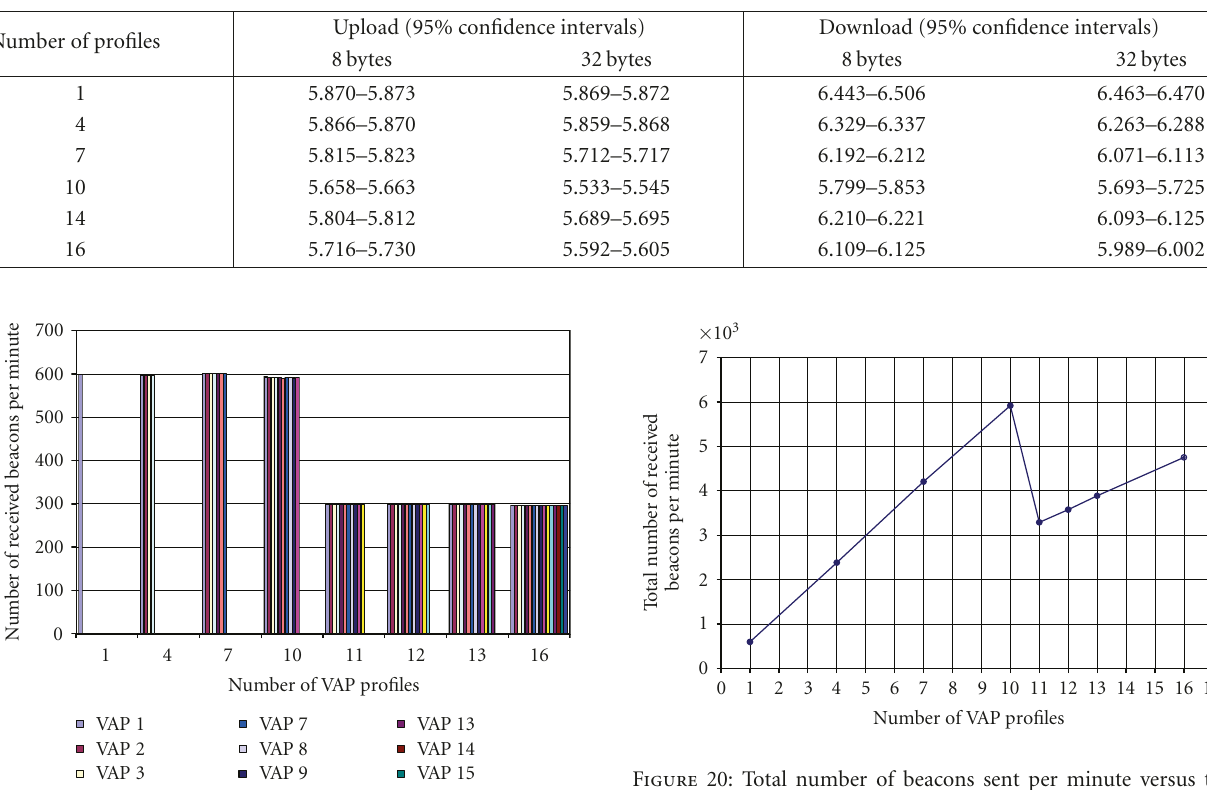
Table 4: Confidence intervals (95%) relevant to the average throughput values plotted in Figure 21.